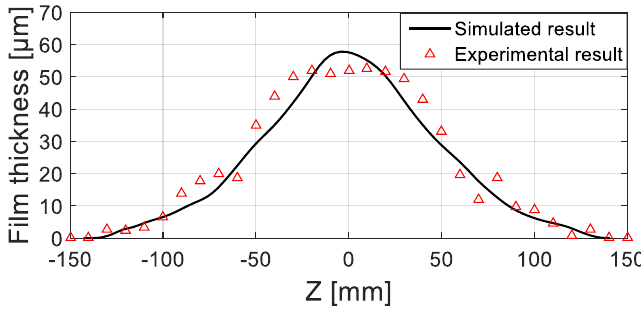
Figure 21. Cylindrical spraying: comparison of experimental and simulated coating film thickness distribution in the plane X = 0.